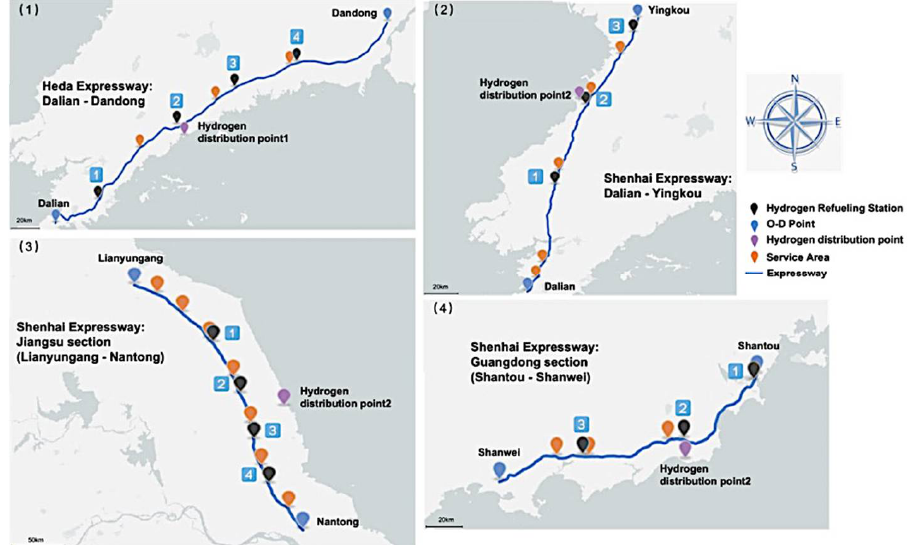
Table 11. Summary of hydrogen distribution points and hydrogen refueling stations.